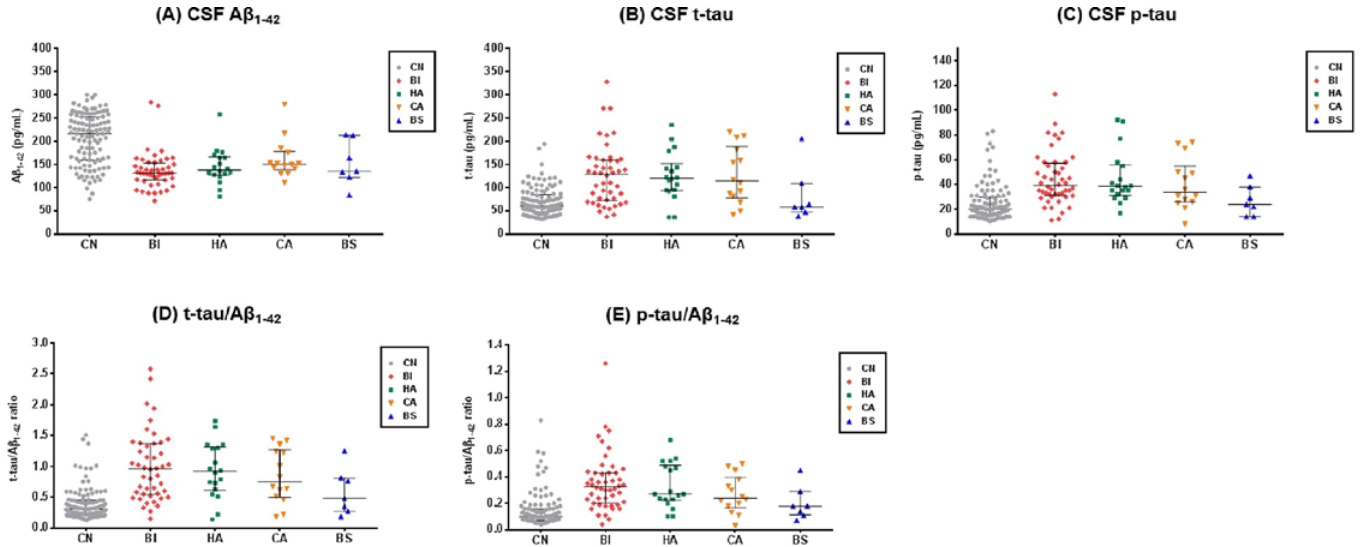
Fig 3. CSF biomarker levels. The dot plots of CSF biomarkers in CN and AD subtypes. Bars indicates median and IQR. (A) CSF A β 1 – 42 , (B) CSF t-tau, (C) CSF p-tau, (D) t-tau/A β 1 – 42 ratio, (E) p-tau/A β 1 – 42 ratio. CN, Cognitively normal; AD, Alzheimer ’ s disease; BI, Both impaired; HA, Hippocampal atrophy only; CA, Cortical atrophy only; BS, Both spared; CSF, Cerebrospinal fluid; A β 1 – 42 = Amyloid- β 1 – 42 peptide; t-tau, total tau; p-tau, phosphorylated